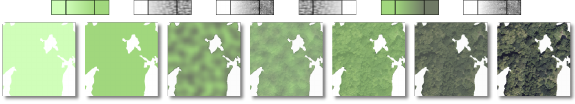
Figure 14: Vegetation symbolization interpolation using several interpolation